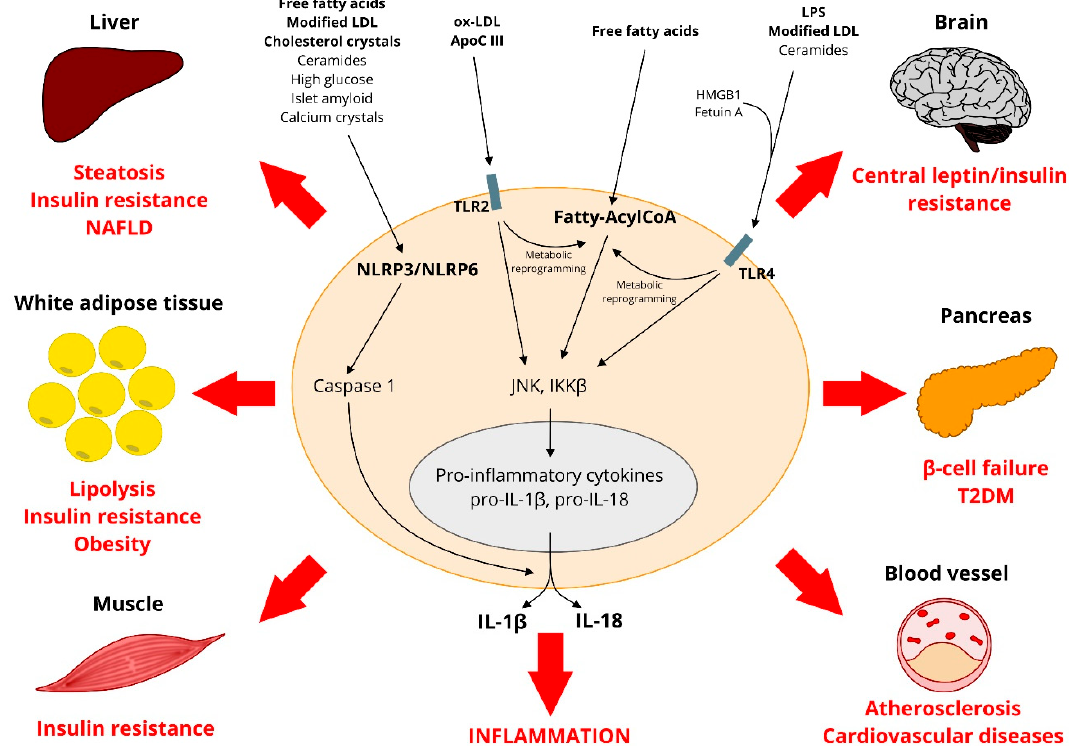
Figure 2. Interaction between lipids and innate immune receptors. Some lipid products, such as oxidized and modified LDL, cholesterol crystals, and ceramides activate innate immune receptors, such as TLR and NLRP3. FFA activate NLRP3, but not TLR. However, TLR-activation is a prerequisite for FFA to induce inflammation. HMBG1 (High Mobility Group Box 1) and fetuin A mediate TLR4 activation. Upon ligand binding, TLR trigger the activation JNK (c-Jun N-terminal kinase) and IKK β (inhibitor of nuclear factor kappa-B kinase subunit β ), leading to the induction of inflammatory gene transcription factors and the expression of proinflammatory cytokines, such as IL-1 β and IL-8. NLRP3 activation leads to the expression of proinflammatory cytokines through the assembly of a large multiprotein complex, the inflammasome. The inflammasome consists of the NLRP3 protein, the adapter apoptosis-associated speck-like protein, and pro-caspase-1. The NLRP3-inflammasome catalyzes the cleavage, activation and secretion of IL-1 β and IL-18. Inflammation promotes the development of steatosis in the liver, adipose lipolysis, peripheral insulin resistance, leptin resistance in the central nervous system, it impairs insulin secretion in the pancreas, and it promotes the development and progression of atherosclerosis, leading to obesity, non-alcoholic fatty liver disease (NAFLD), type 2 diabetes mellitus (T2DM) and cardiovascular diseases (CVD).